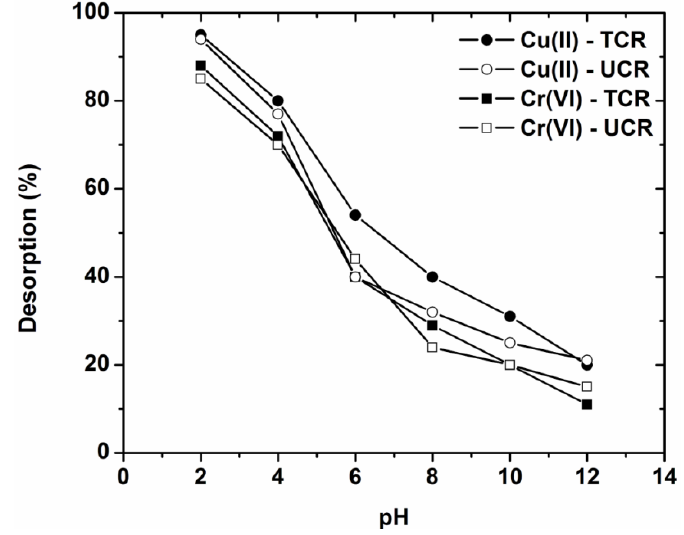
Figure 6. Effect of pH on desorption of Cu(II) and Cr(VI) onto treated and untreated coffee residues (pH = 2–12, 1 g/L adsorbent, T = 25 °C, 140 rpm, 24 h